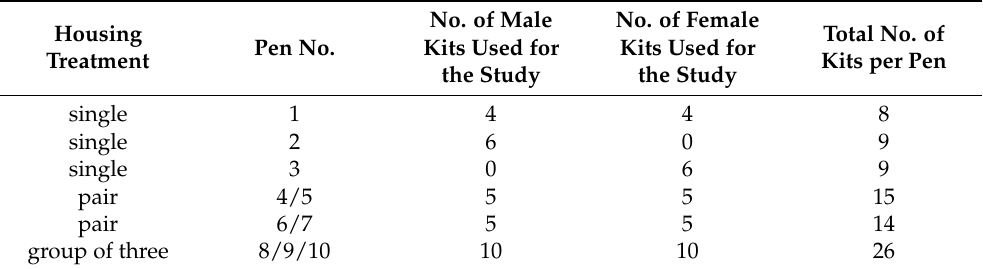
Table 1. Number and housing treatment (group size of does) of male and female kits used for the study. No. of Male No. of Female Total No. Housing Kits Used for Pen No.